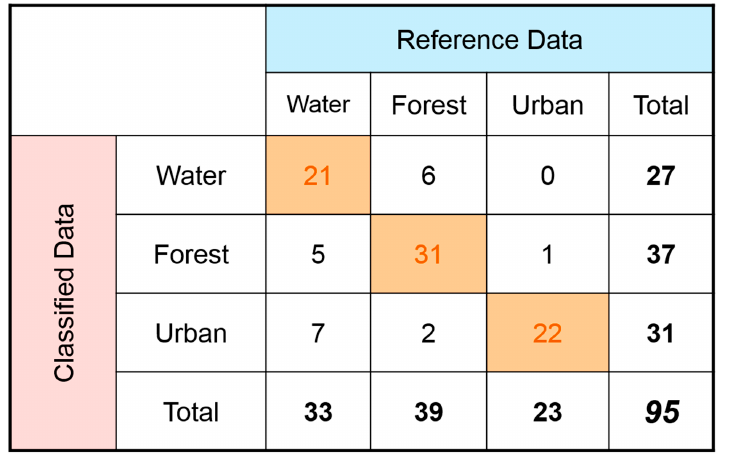
Figure A2. Example confusion matrix. The classified data indicate the ML/DL model predicted results and the reference data refer to the actual manually annotated data (image source: [166]). The kappa statistic can be calculated by the following formula, where Pr(a) repre- sents the actual observed agreement, and Pr(e) represents expected (i.e., estimated) chance agreement). Thus, Pr(a) = OA.